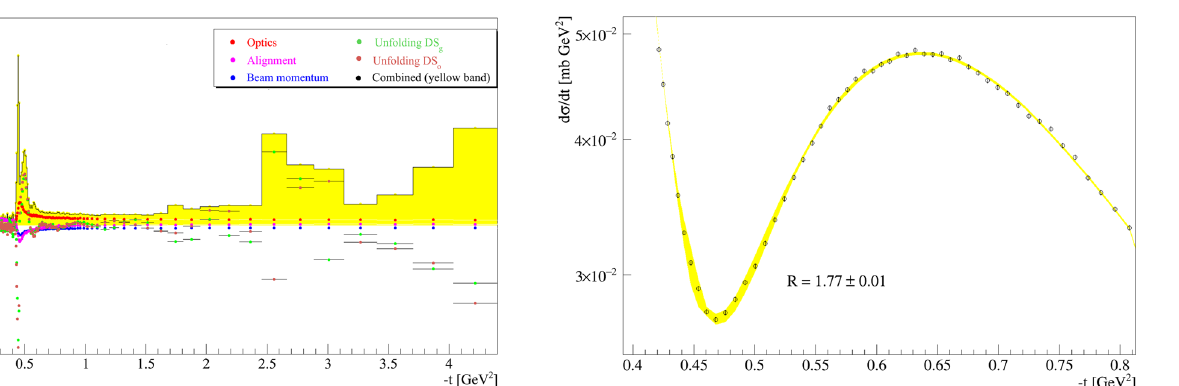
Fig. 11 The diffractive minimum has been observed with high sig- nificance at 13 TeV. The uncertainty on the points is the statistical uncertainty, while the yellow band shows the full uncertainty, includ- ing the systematic part. The dip position has been found to be | t dip | = ( 0 . 47 ± 0 . 004 stat ± 0 . 01 syst ) GeV 2 andthedifferentialcrosssectionratio between the second maximum and the minimum is R = 1 . 77 ± 0 . 01